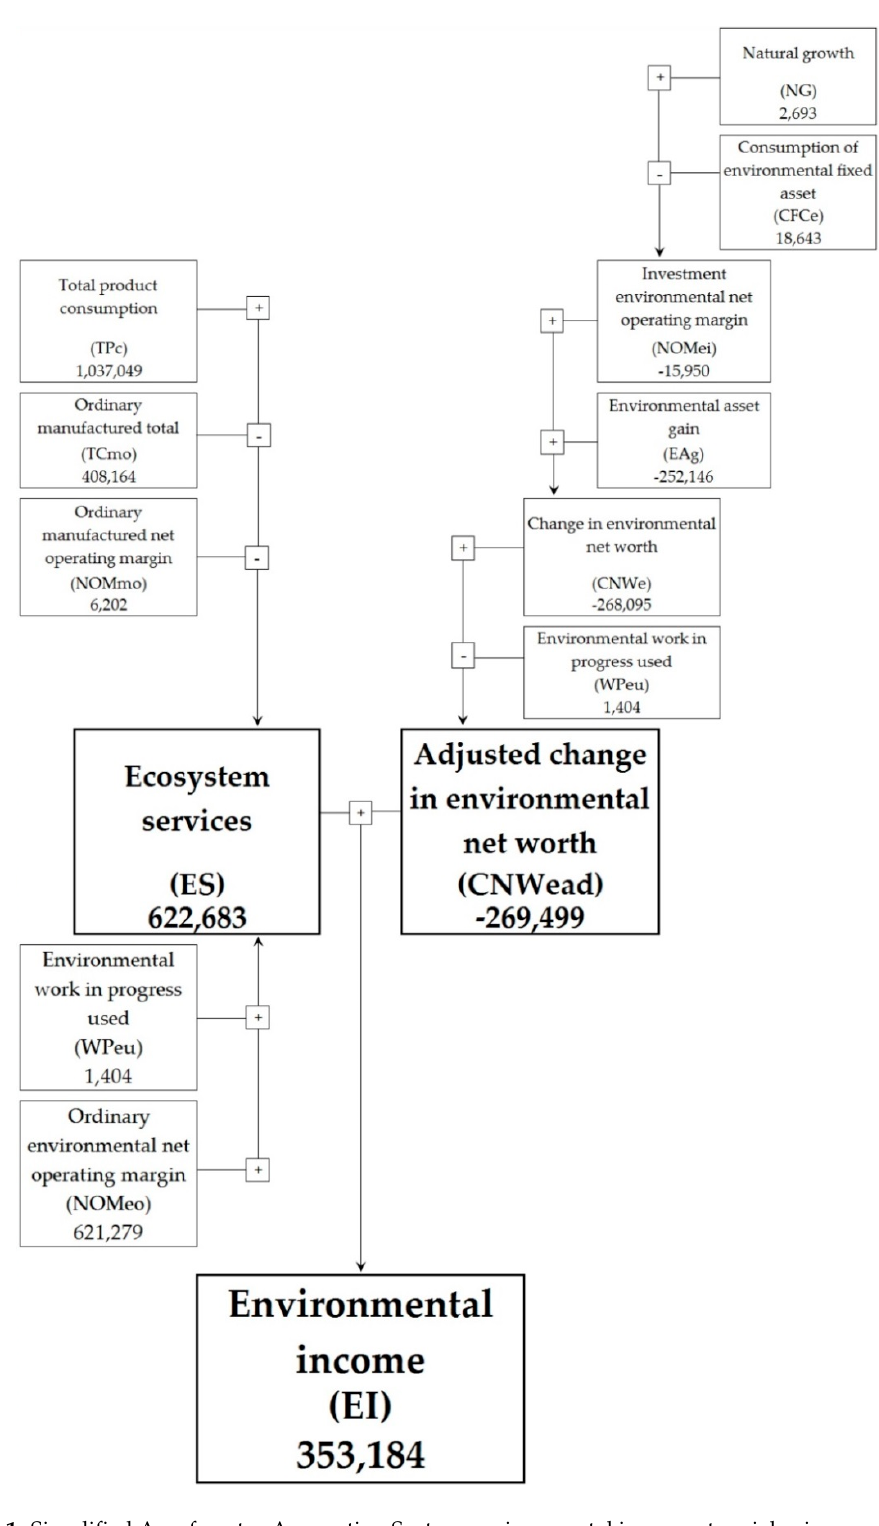
Figure 1. Simplified Agroforestry Accounting System environmental income at social price measured in Andalusian holm oak open woodlands (2010: thousand euros). Source: Own elaboration based on [8]. Andalusian holm oak woodland surface: 1,408,170 hectares.